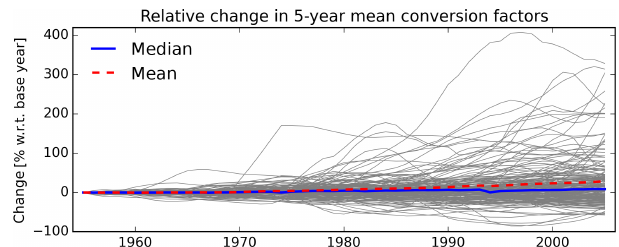
Figure 3. Base year dependent relative change in 5-year running- mean conversion factors for all 181 countries (gray lines) for which a 5-year mean can be determined. The cross-country mean (red- dashed) and the median (blue-solid) conversion factor increase by 28.2 and 8.4% between 1954 and 2005,